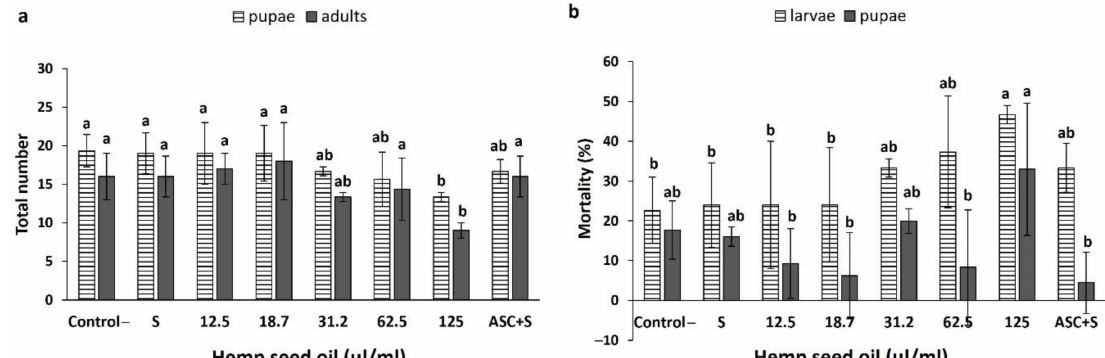
Figure 6. Effects of hemp seed oil and ascorbic acid on the total numbers of formed pupae and eclosed adults ( a ) and percentages of larval and pupal mortality ( b ) under chronic H 2 O 2 -induced oxidative stress. The hemp seed oil was applied to the H 2 O 2 -contained feeding medium at six concentrations (0 (S), 12.5, 18.7, 31.2, 62.5, and 125 µ L/mL) and compared to an unstressed negative control (control-) and a positive control of ascorbic acid (ASC + S). All values are expressed as means ± SD. Different letters above the means represent significant differences between treatments separately for larvae, pupae, or eclosed adults ( p < 0.05; LSD